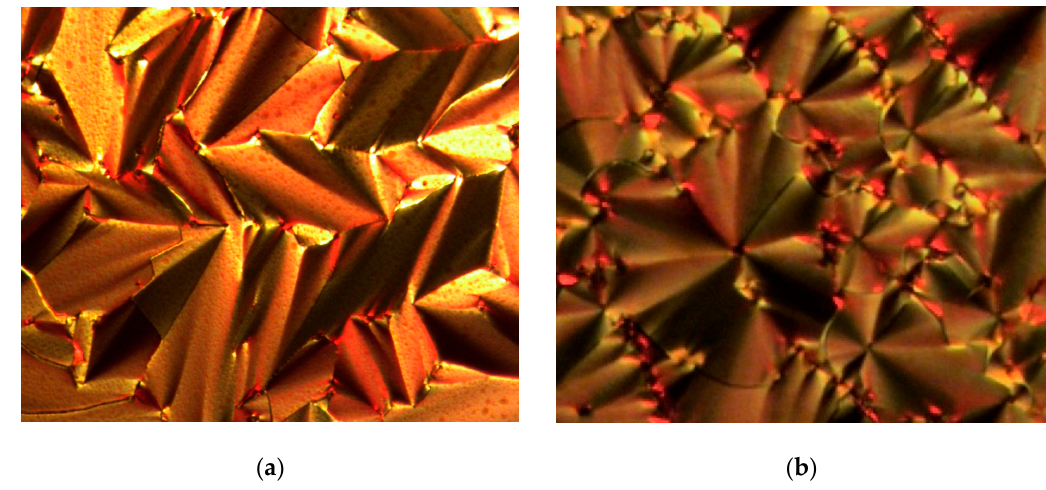
Figure 12. The optical photomicrographs of compounds 6a , b in the heating cycle showed the focal conic fans of SmA, ( a ) compound 6a at 180.45 ° C and ( b ) compound 6b at 175.38 ° C (Magnification of 20 × 0.50).